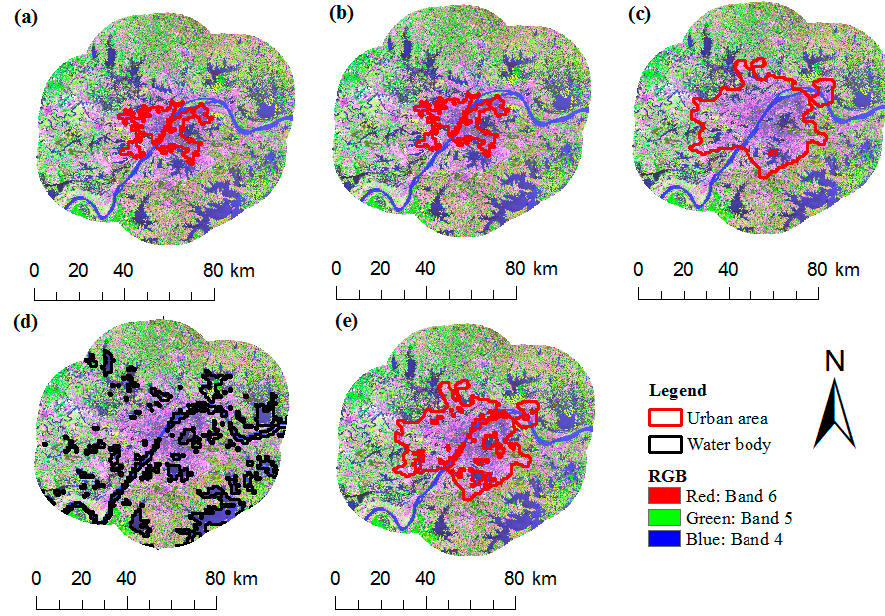
Figure 2. The comparison of different data and methods of extracting the urban areas or water body in WH: ( a ) urban areas in WH extracted from MODIS land cover data (LCD) in 2001; ( b ) urban areas in WH extracted from MODIS LCD in 2013; ( c ) urban areas in WH extracted from stable nighttime light data in 2013; ( d ) the union areas of water body in WH extracted from MODIS LCD; ( e ) SNLD and MODIS LCD were combined to produce the urban areas in WH. The background map was Landsat OLI image from 16 August 2013.